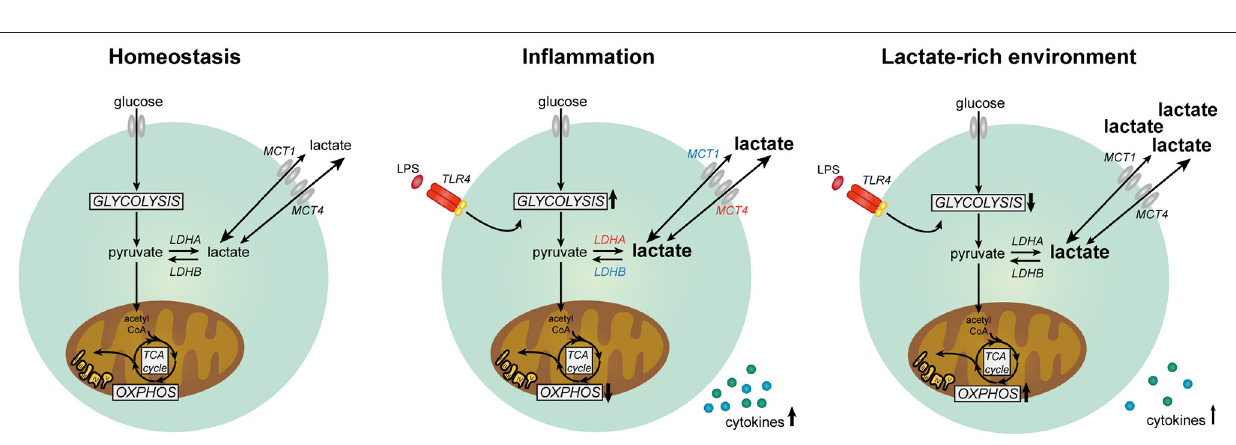
Frontiers in Immunology |